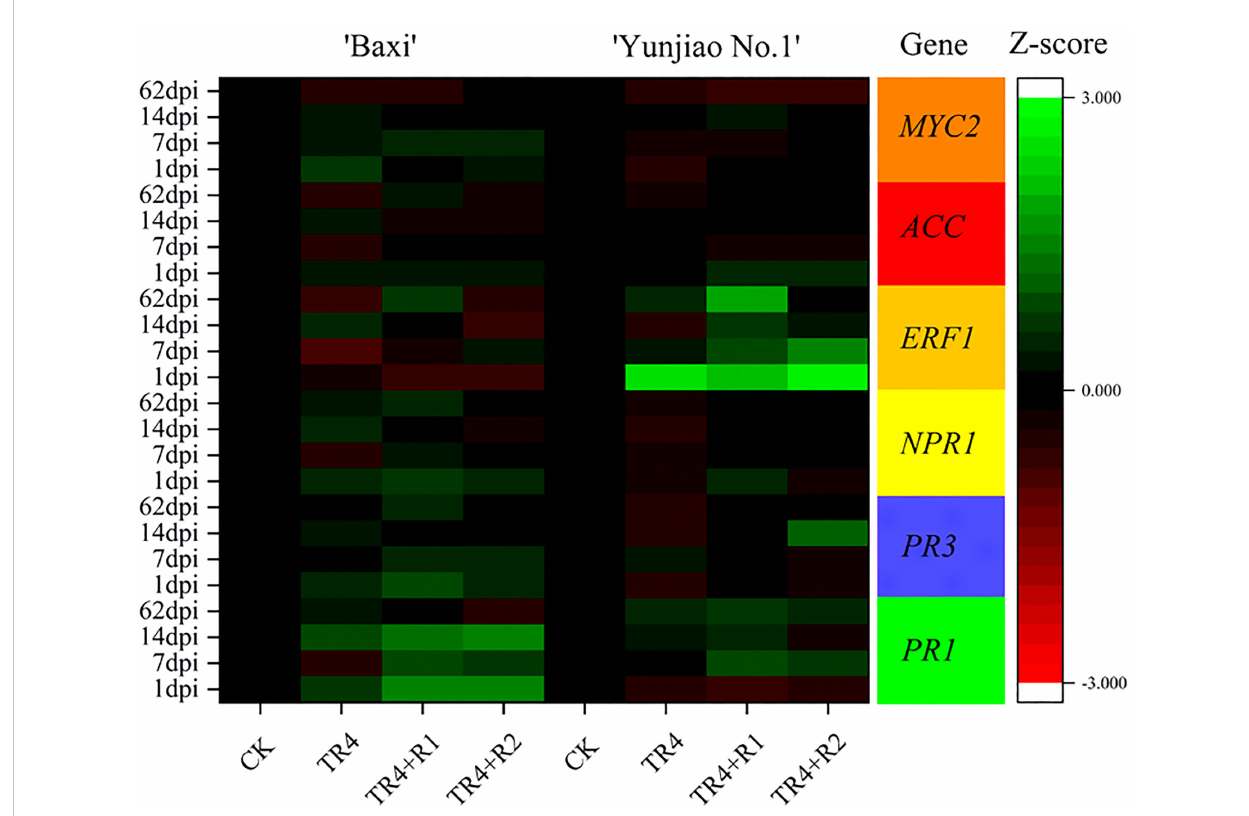
FIGURE 7 Relative expression levels of key genes that induce resistance in corms at 1 dpi to 62 dpi. The heat map illustrates the doubled changes of gene expression (log10 scale) in corms at 1 dpi, 7 dpi, 14 dpi and 62 dpi. Different color means induced or repressed gene expression (Red indicates down-regulation of gene expression; green indicates up-regulation of gene expression; black indicates no effect on gene expression). Three biological replicates and three technical replicates were used in data analysis. MYC2, basic helix-loop-helix (bHLH) transcription factor; ACC, 1- aminocyclopropane-1-carboxylic acid synthase; ERF1, ethylene response factor 1; NPR1, nonexpressorofpathogenesis-relatedgenes1; PR3, pathogenesis-related 3 genes; PR1, pathogenesis-related 1